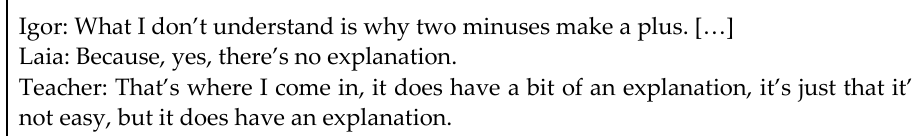
Figure 11. Fragment of the sequence of interventions that defined connection CC5.